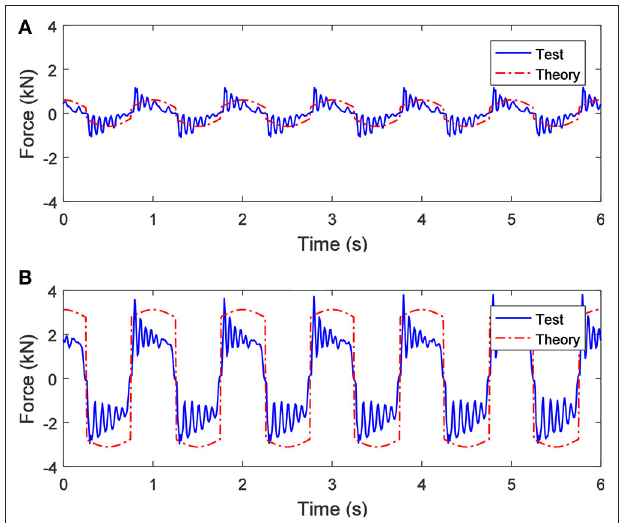
FIGURE 6 | When the applied current is different, the output force of the SAI under a sinusoidal displacement excitation with a frequency of 1.0Hz and an amplitude of 20 mm: (A) 0A and (B) 1.0A.